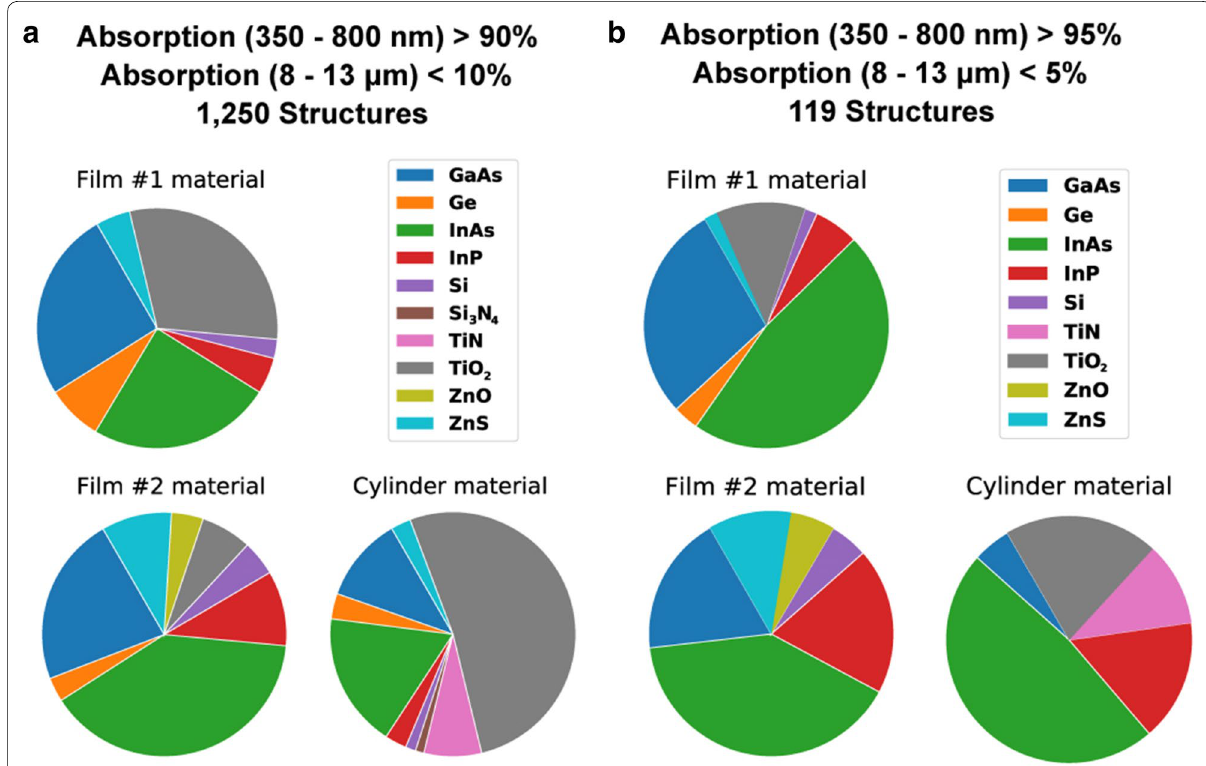
Fig. 3 Pie charts of ( a ) the material distributions of film #1, film# 2 and the cylinder for structures with an AUC higher than 90% from 350 to 800 nm and an AUC lower than 10% from 8 to 13 μm (1250 structures) and ( b ) for the structures with an AUC higher than 95% from 350 to 800 nm and an AUC lower than 5% from 8 to 13 μm (119 structures)